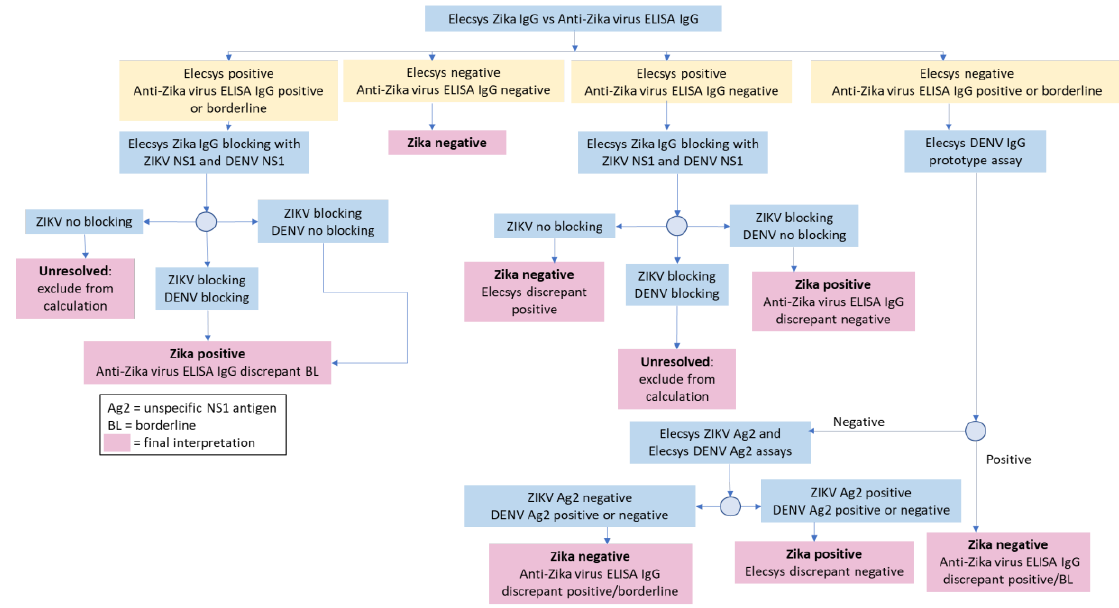
Figure 1. Resolution testing algorithm.